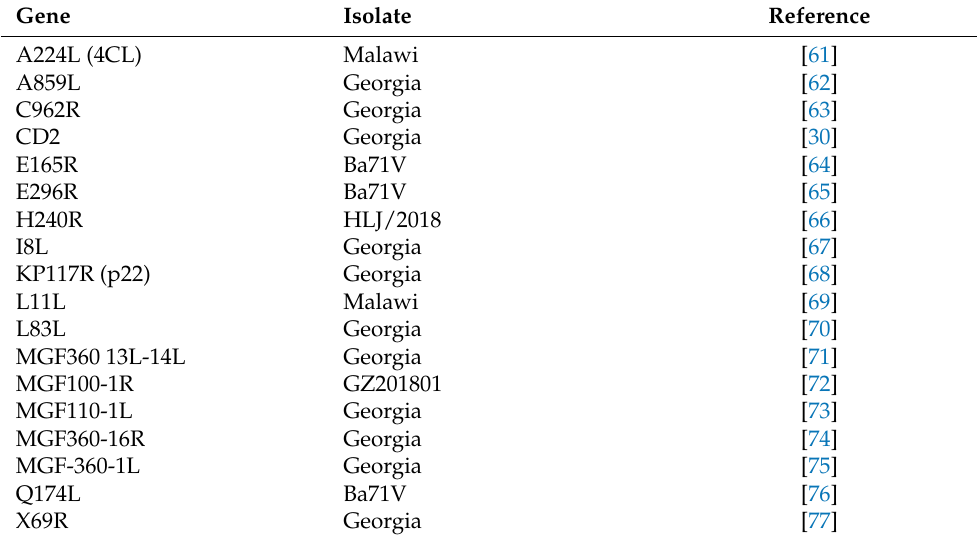
Table 4. Single deletions in ASFV that resulted in no phenotype.